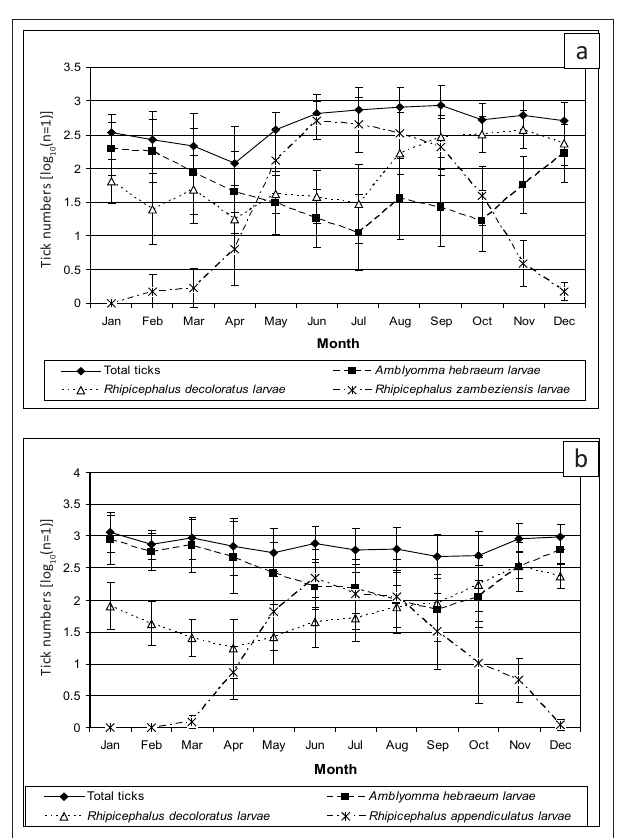
FIGURE 3: Mean (± 95% confidence interval) of the total number of ticks and of the larvae of the three major tick species by month at a) Skukuza and b) Nhlowa Road.